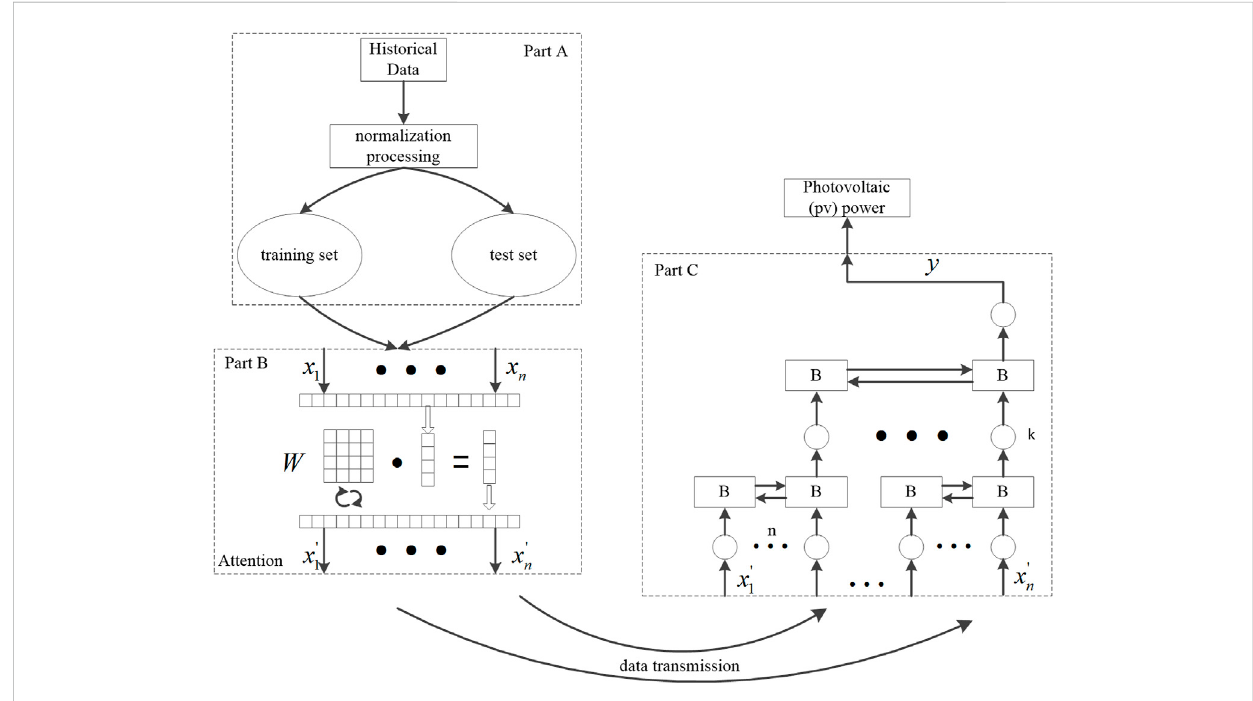
FIGURE 4 Model structure